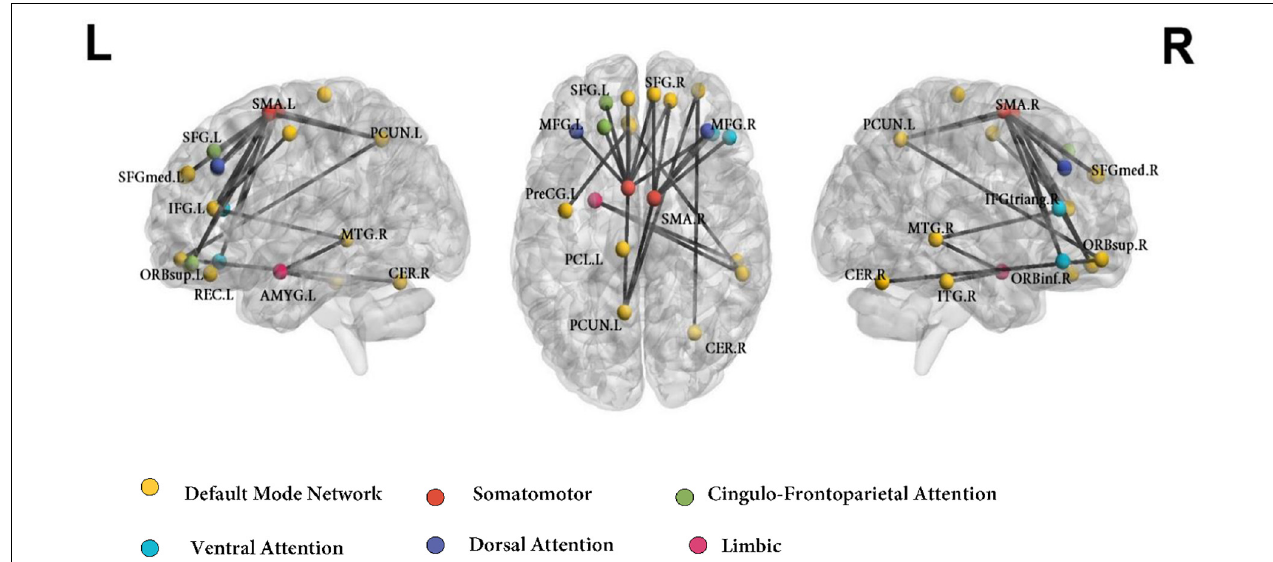
FIGURE 1 | Functional connectivity networks differentiating ADHD-C and Control groups using the AAL atlas. Colors of the AAL nodes represent the intrinsic brain networks that they belong to from mapping functional parcelation atlas onto Yeo’s seven resting-state network atlas. DMN, default mode network; CFP, cingulo-frontoparietal network; SSN, somatomotor; VAN, ventral attention network; DAN, dorsal attention network; L, left; R, right. ORBinf.R, inferior frontal gyrus, orbital part (Right); MFG.L, middle frontal gyrus (Left); SFGdor.L, superior frontal gyrus, dorsolateral (Left); SFGmed.L, superior frontal gyrus, medial (Left); SFGmed.R, superior frontal gyrus, medial (Right); ORBsup.L, superior frontal gyrus, orbital part (Left); ORBsup.R, superior frontal gyrus, orbital part (Right); IFGtriang.R, inferior frontal gyrus, triangular part (Right); ORBmid.R, superior frontal gyrus, medial orbital (Right); MFG.R, middle frontal gyrus (Right); PreCG.L, precentral gyrus (Left); SMA.L, supplementary motor area (Left); SMA.R, supplementary motor area (Right); ACG.L, anterior cingulate gyrus (Left); AMYG.L, amygdala (Left); REC.L, gyrus rectus (Left); PCUN.L, precuneus (Left); CER.R, cerebellum (Right); MTG.R, middle temporal gyrus (Right); ITG.R, inferior temporal gyrus (Right); PCL.L, paracentral lobule